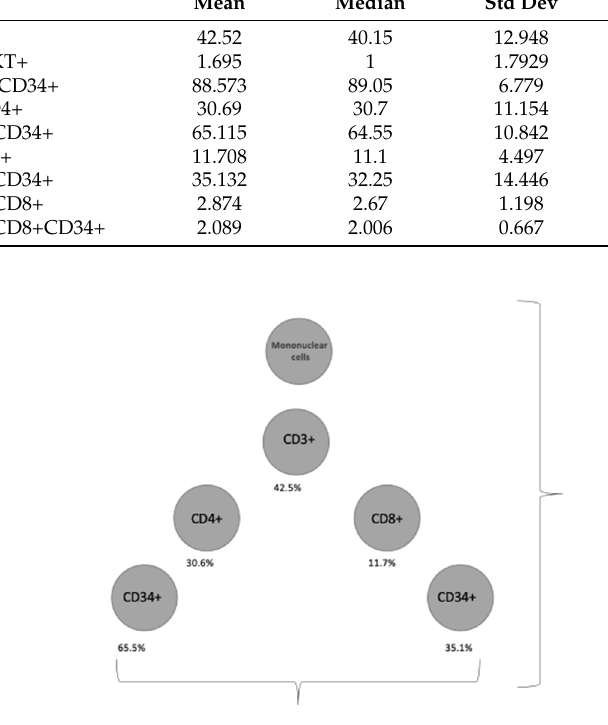
Figure 3. Cellular subsets.